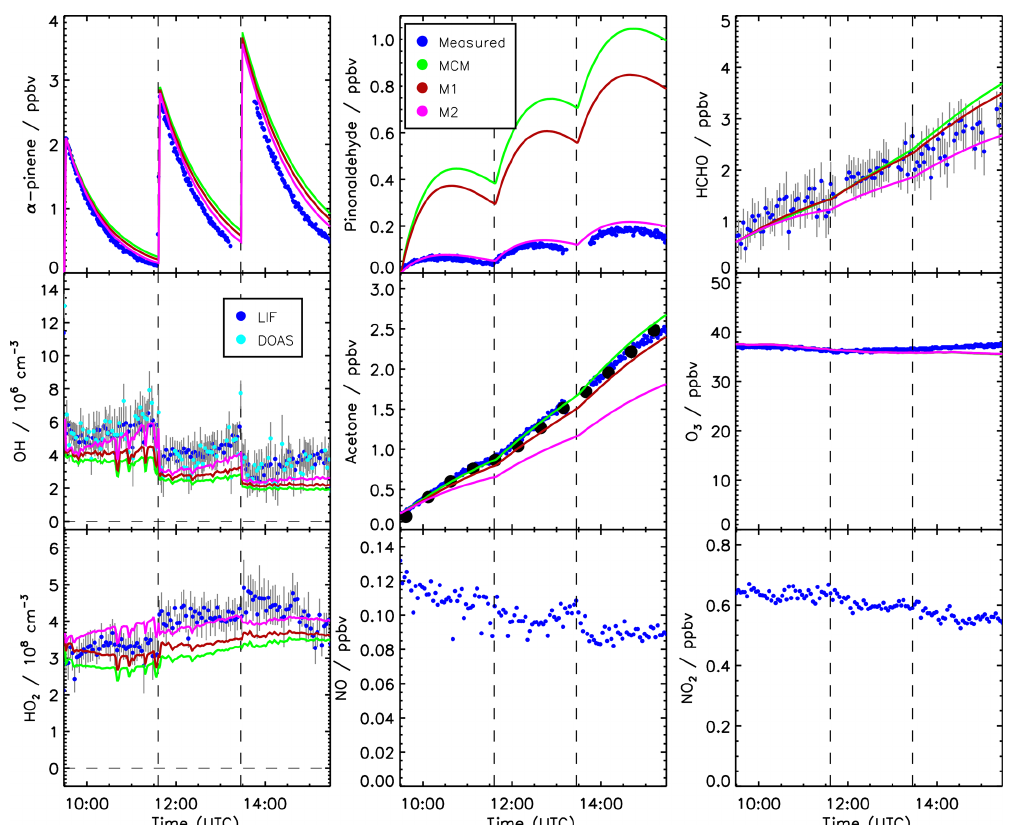
Figure 4. Time series of measured and modeled concentrations of radicals and inorganic and organic compounds during the α -pinene photooxidation at low NO (experiment on 2 July